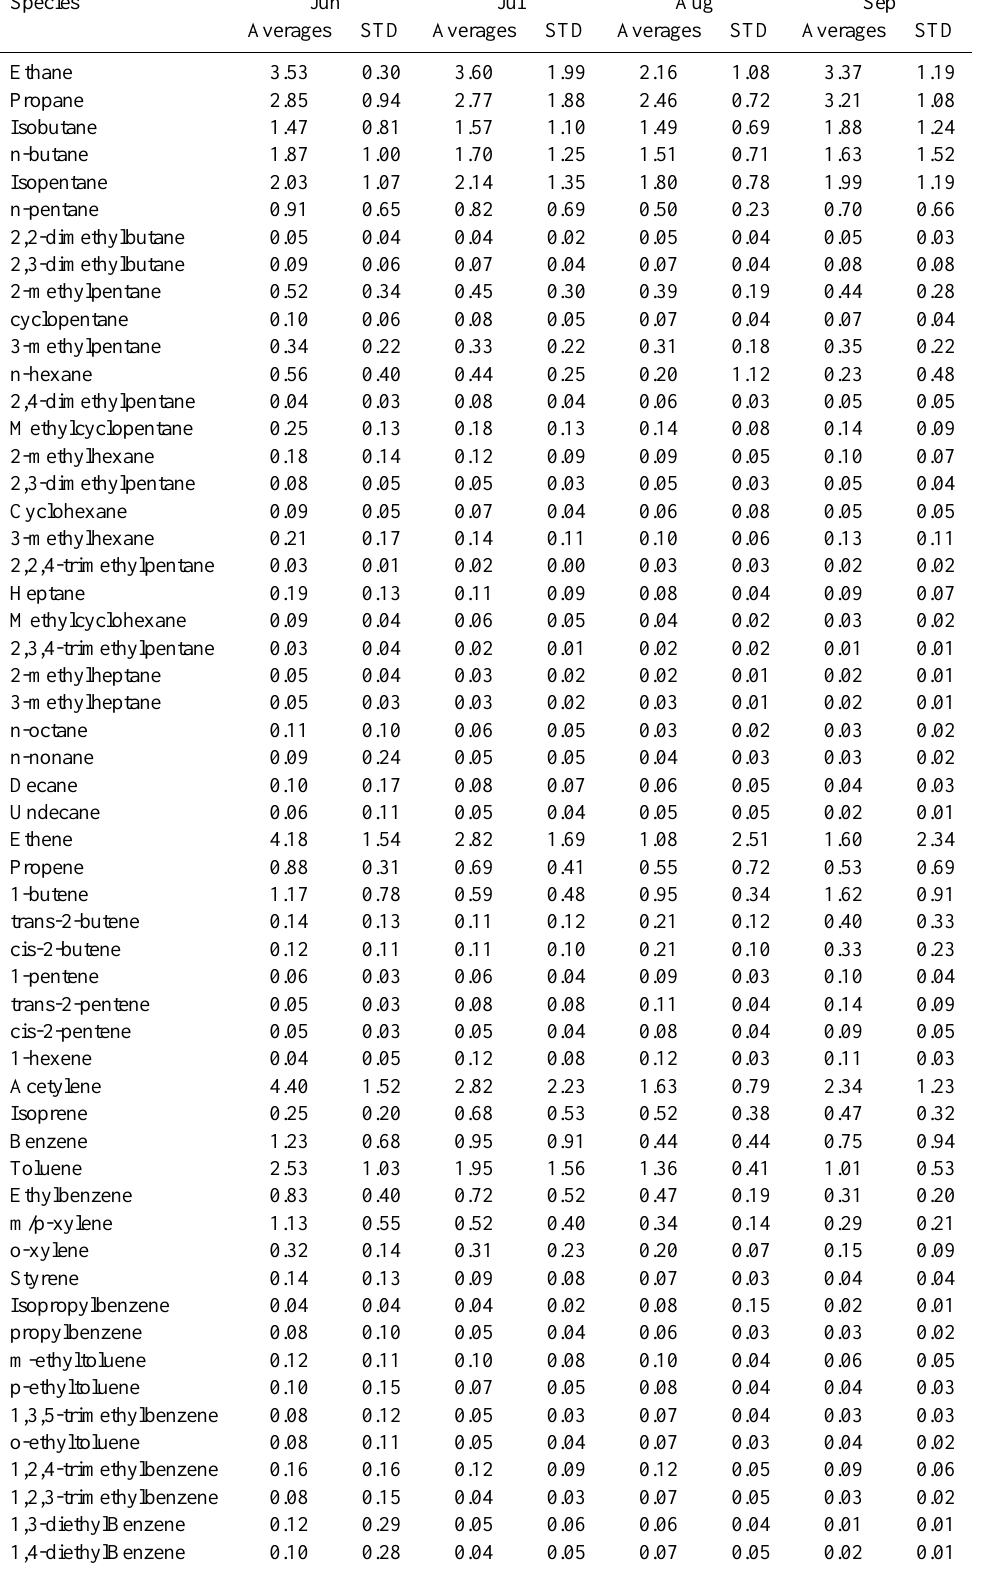
Table 5. The levels of NMHC species measured at PKU site from June to September. (Unit: ppbv)